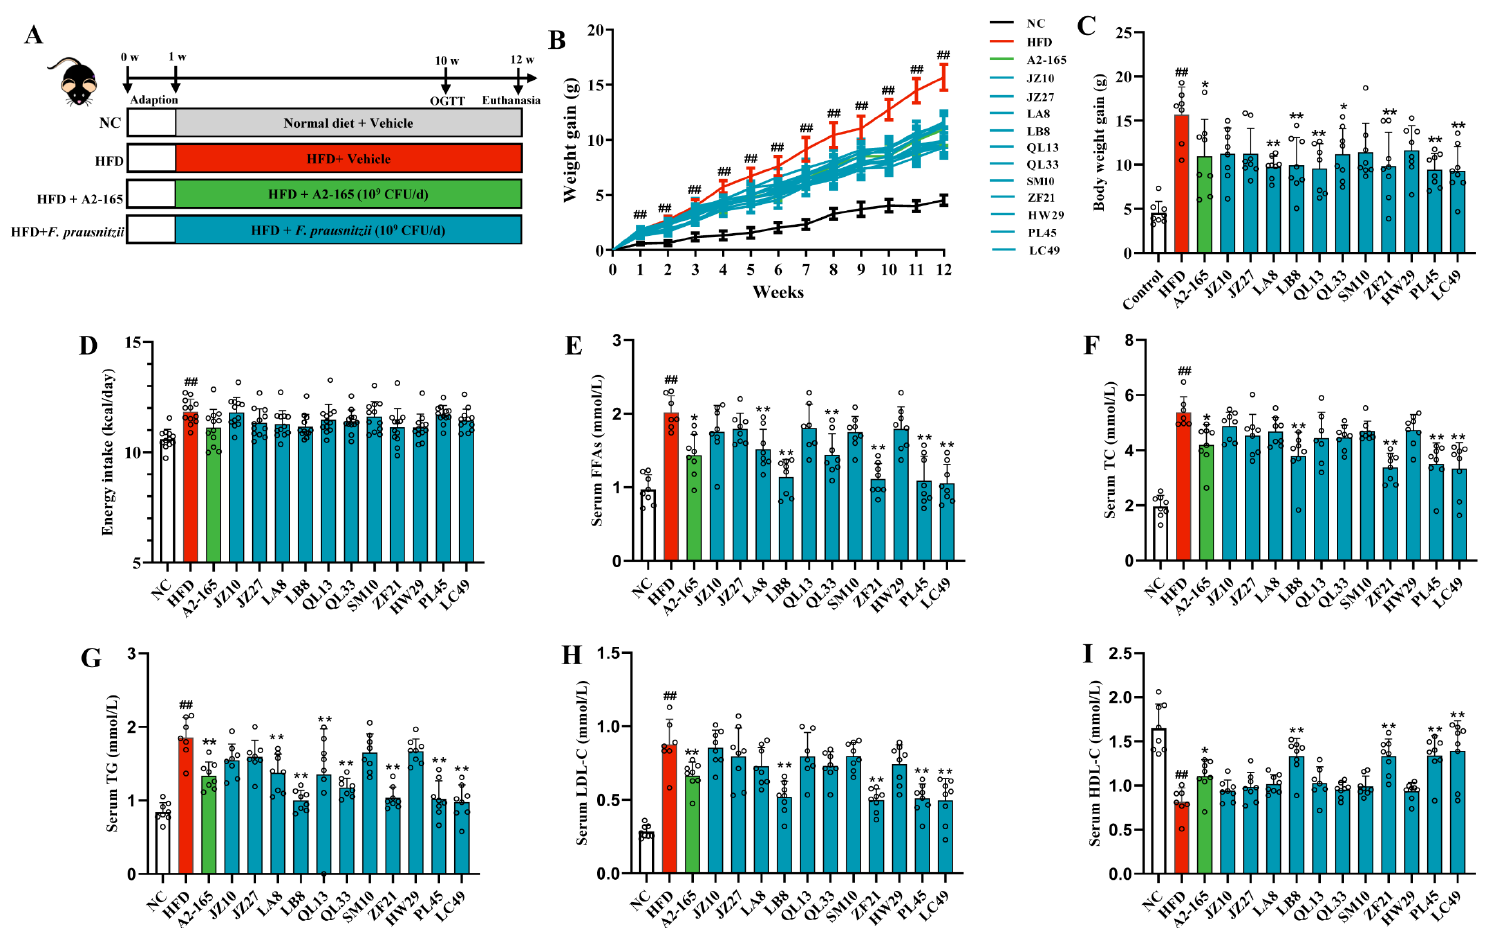
Figure 1. The effect of F. prausnitzii strains on body weight gain, energy uptake, and serum lipid profiles in NAFLD mice. ( A ) Animal groups and experimental schedule; ( B ) Changes in the body weight gain of HFD-fed mice with or without F. prausnitzii treatment; ( C ) Final body weight; ( D ) Energy intake in different groups; ( E – I ) Serum levels of FFAs, TC, TG, LDL-C, and HDL-C in different groups. Data are shown as means with SD; ## p < 0.01 vs. NC group, unpaired Student’s t -test; * p < 0.05, ** p < 0.01 vs. HFD group, one-way ANOVA followed by Dunnett’s